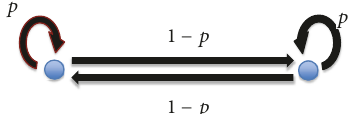
Figure 1: Graphical representation of the family of graphs with two nodes, equal strength self loops, and equal strength connecting edges.